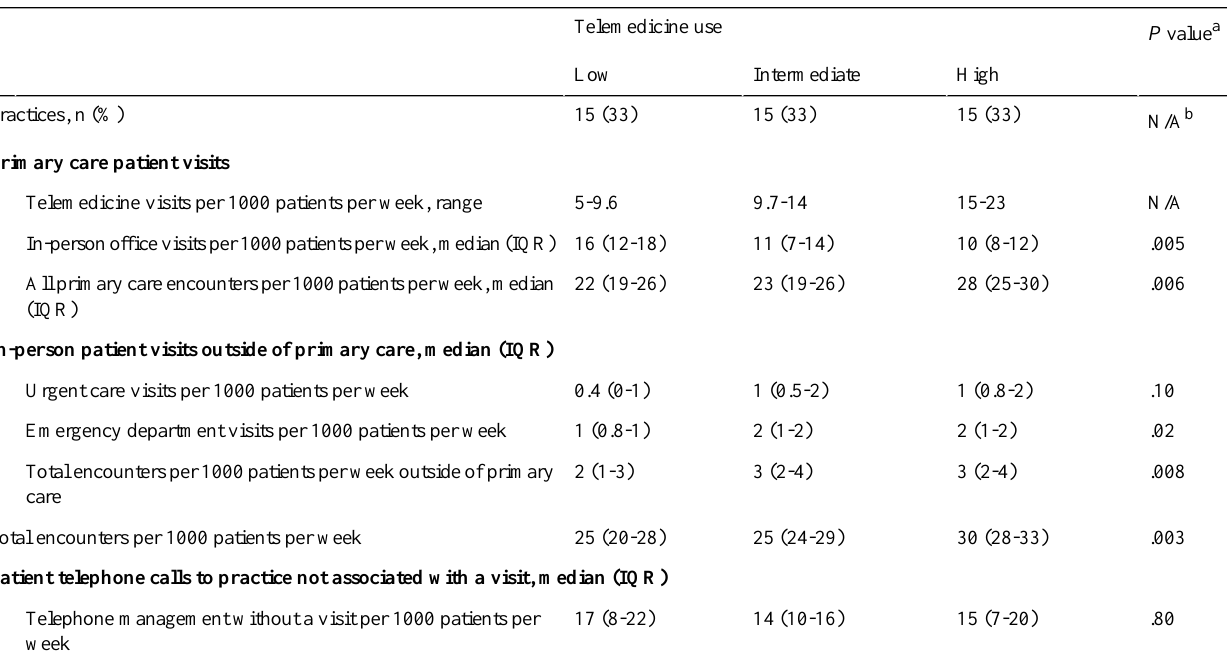
Table 3. In-person visits by patients in practices with low, intermediate, or high telemedicine use (April 19 to May 2,